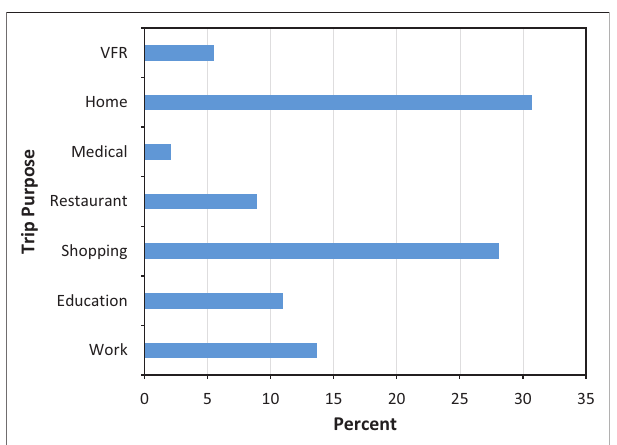
FIGURE 2: Trip purpose.